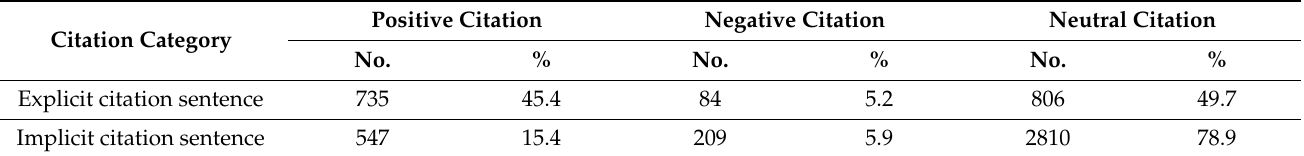
Table 10. Distribution of different citation sentiments in explicit and implicit citation